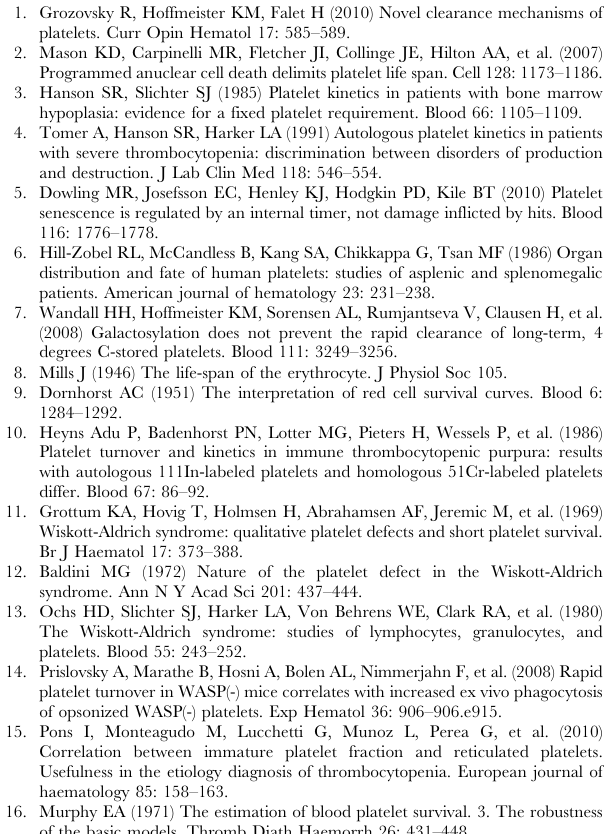
Figure S9 Semi-log plot of WASP(-) to WASP(-) platelet consumption data (n= 18). The Excel-generated linear regression